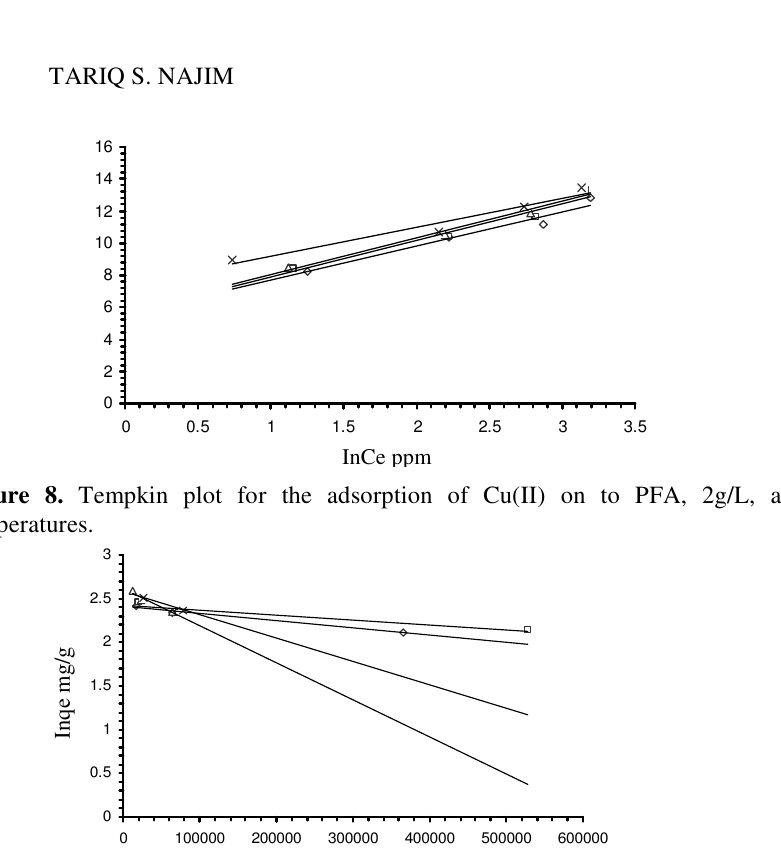
Figure 9. D-R plot for the adsorption of Cu(II) onto PFA 2g/L at different temperatures . Table 2. Equilibrium parameters and correlation coefficients calculated for various adsorption models at different temperatures for adsorption of Cu(II) on to